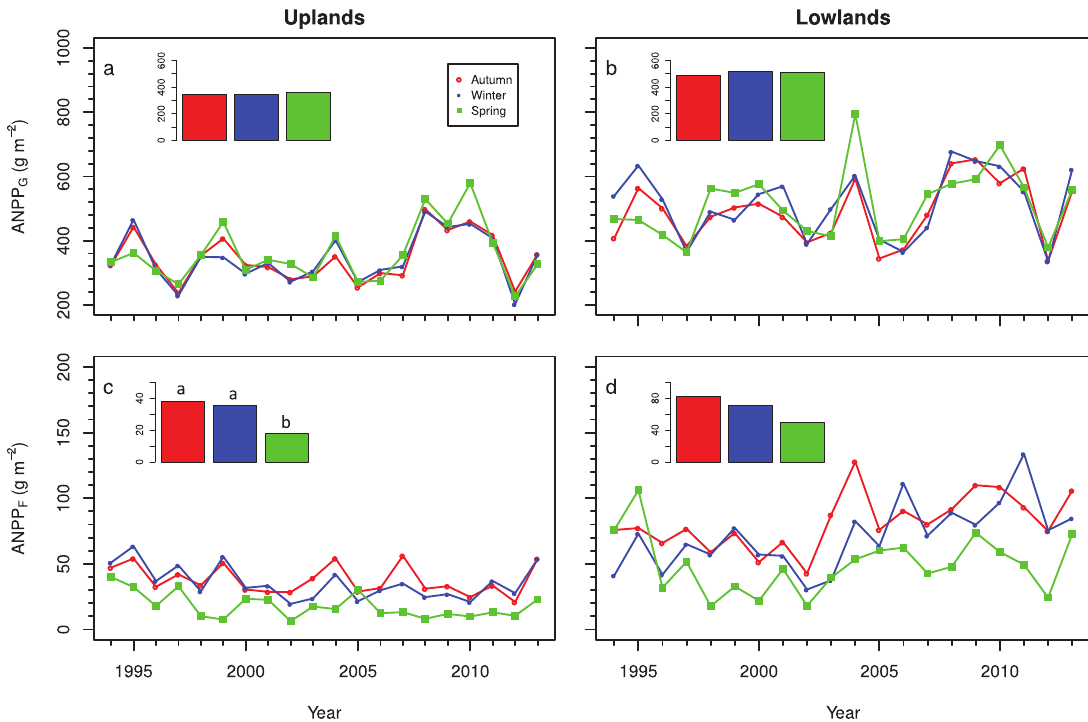
Figure 1. Changes in upland and lowland grass (a,b) and forb (c,d) productivity over time for autumn-, winter-, and spring-burned watersheds on upland (a,c) and lowland (b,d) positions. Inset in each graph represents the 20 year mean with means that were significantly different ( P , 0.05) denoted with different letters.